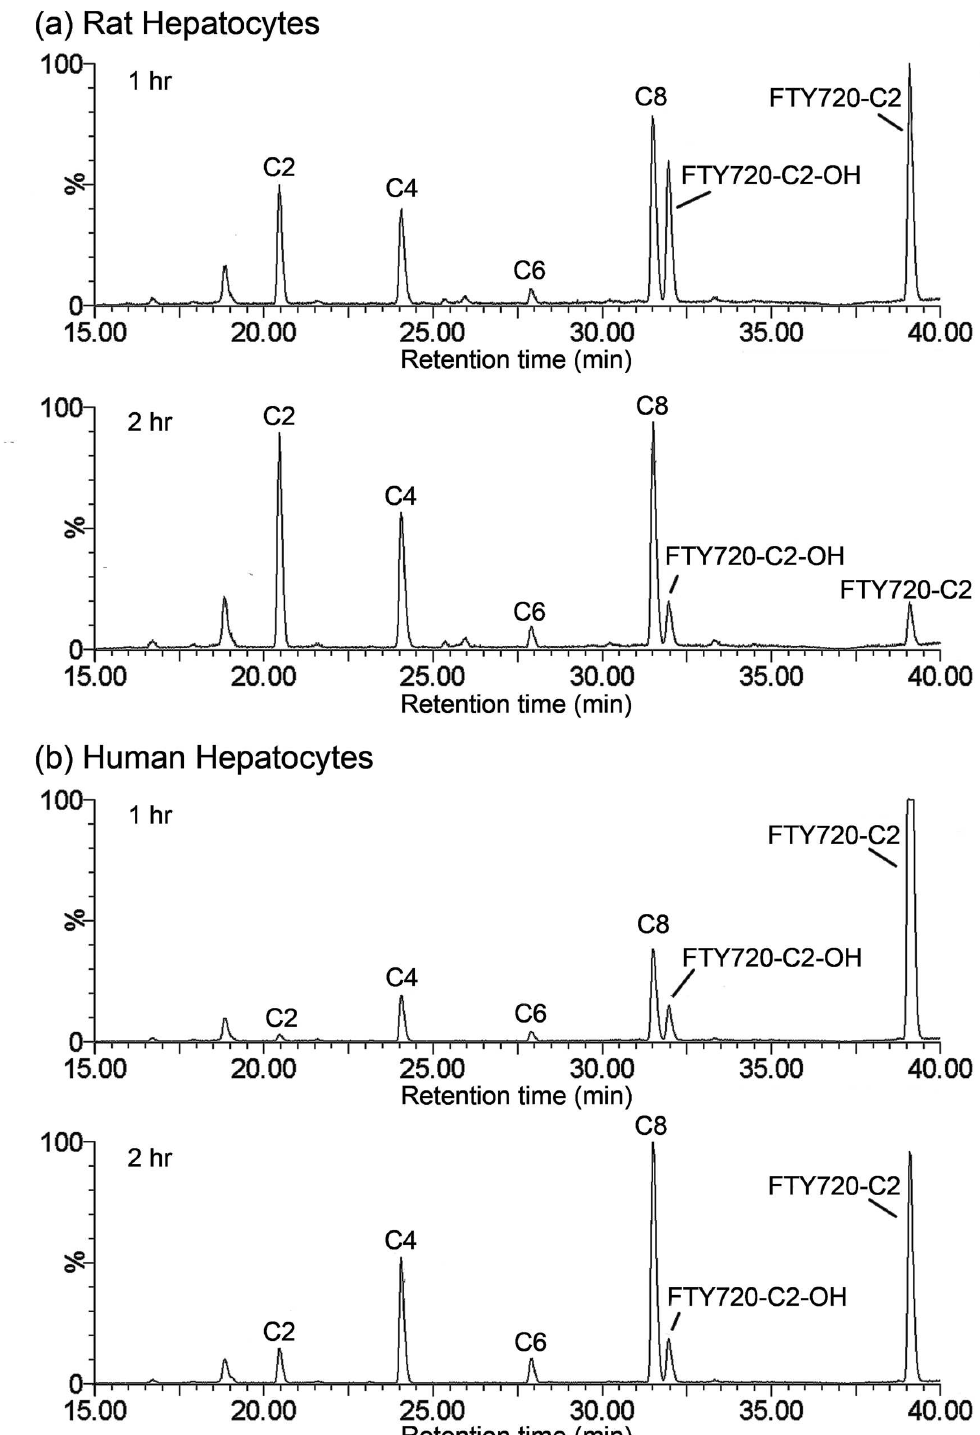
Fig 1. RepresentativeLC/MRM Chromatogram of FTY720-C2 Metabolite Profile. Using 1 μ M of FTY720-C2, we incubated rat (a) and human(b) hepatocytes to obtainthe metabolite profile. To simplifypresentation, the 0 min incubation timepoint,data are intentionallynot shown. Legend: C2 , FTY720-C2 C2-carboxylic acid; C4 , FTY720-C2 C4-carboxylic acid; C6 , FTY720-C2 C6-carboxylic acid; C8 , FTY720-C2 C8-carboxylic acid; FTY720-C2-OH ,hydroxy